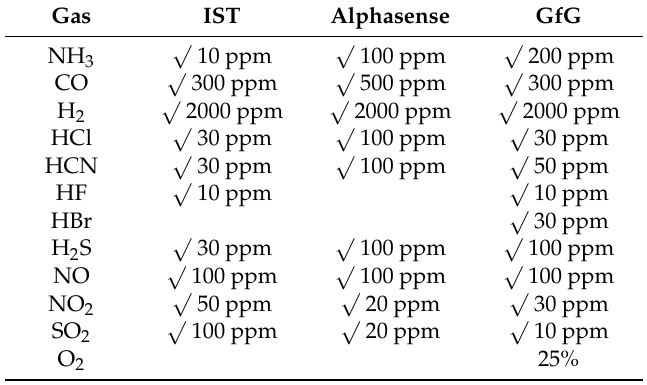
Table 4. Concentration measurement ranges (in ppm) for fire emissions provided by different vendors.